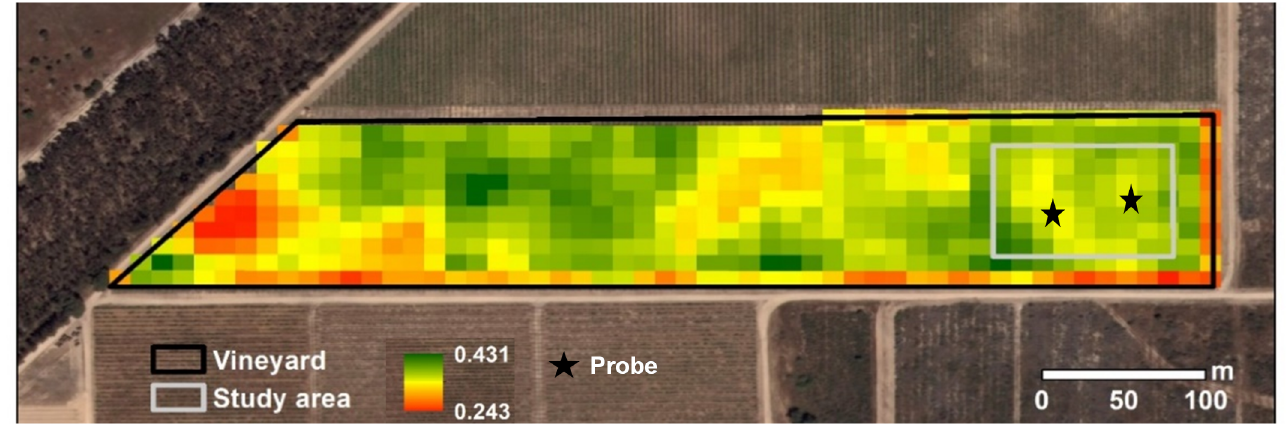
Figure 2. NDVI image for the study area on 7 July 2020.